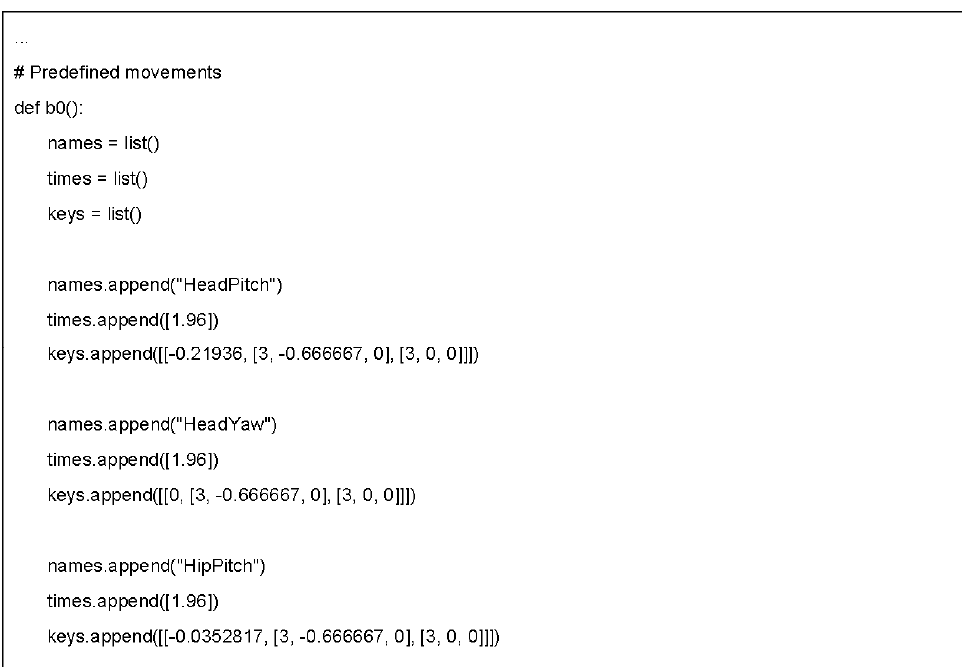
Figure 7. Script of spatial model of cultural meaning. For starting the script at the beginning of the experiment, only one class and five empty instances were predefined. 5.2. Results of the Experiment Evaluation of research question 1: As part of the “European Robotics Week”, we invited the public, and there were other appeals in the form of press releases inviting people to the “Long Night of the Robots” at Vienna University of Technology. The organizers were overwhelmed by the response (more than 1000 visitors). This large number of visitors exceeded our expectations and greatly strained our resources. We had an opportunity to do narrative interviews with mainly lay people, but also with a philosopher specializing in Philosophy of Technology, a psychoanalyst, and several researchers in the field of robotics. However, a total of 258 interactions between visitors and the robot Romeo could be recorded.